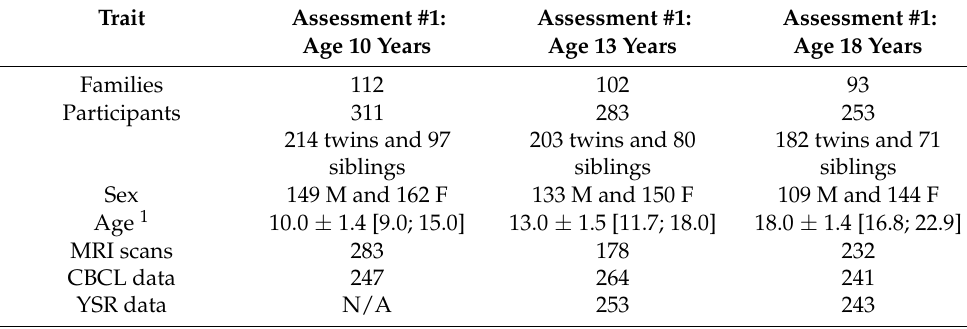
Table 2. Demographics and background information for the BrainSCALE twin cohort.